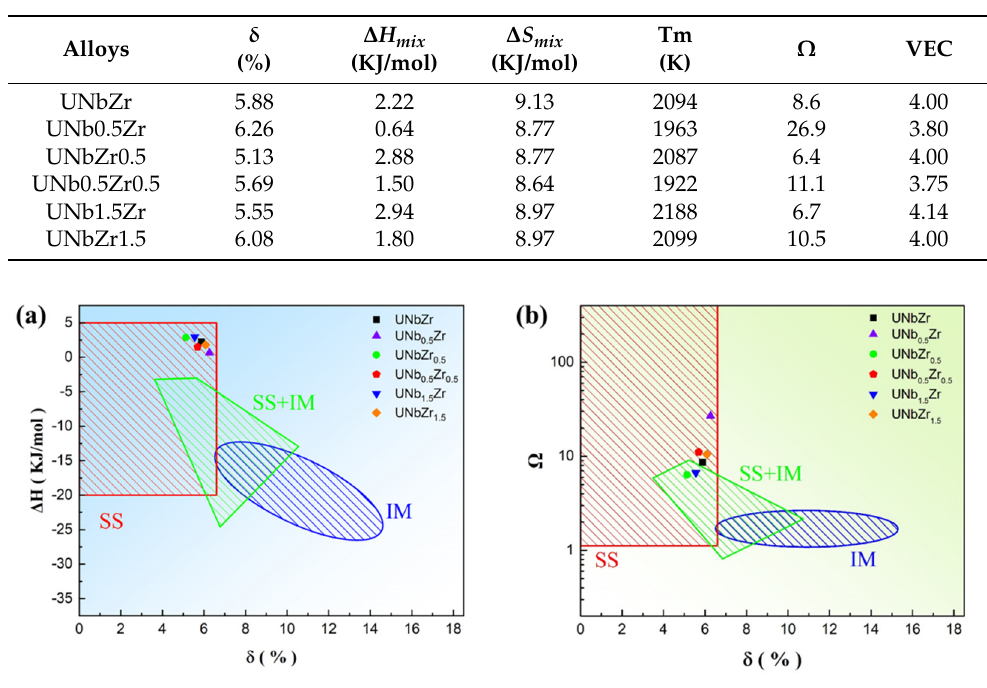
Table 4. Thermodynamic parameters of the U-Nb-Zr alloy system.